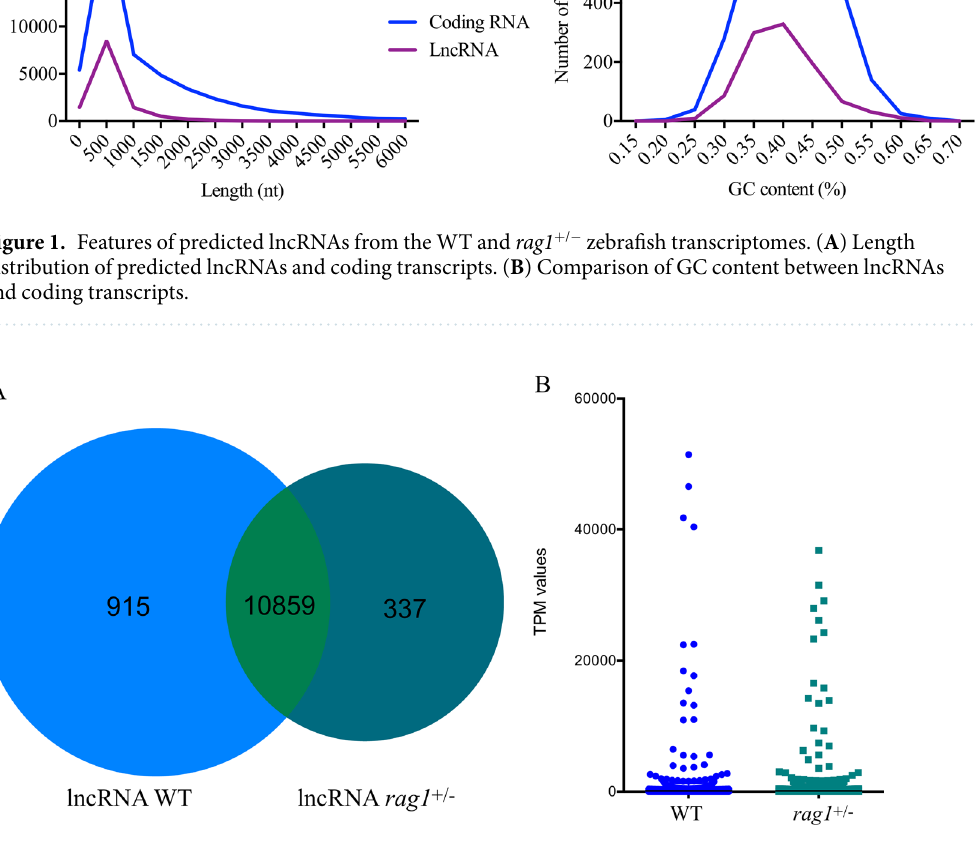
Figure 2. Features of predicted lncRNAs expressed in kidneys of WT and rag1 + / − zebrafish. ( A ) Venn diagram representation of shared and exclusive lncRNAs constitutively expressed in both zebrafish lines. ( B ) Profile of TPM values for common lncRNAs expressed in WT and rag1 + / −